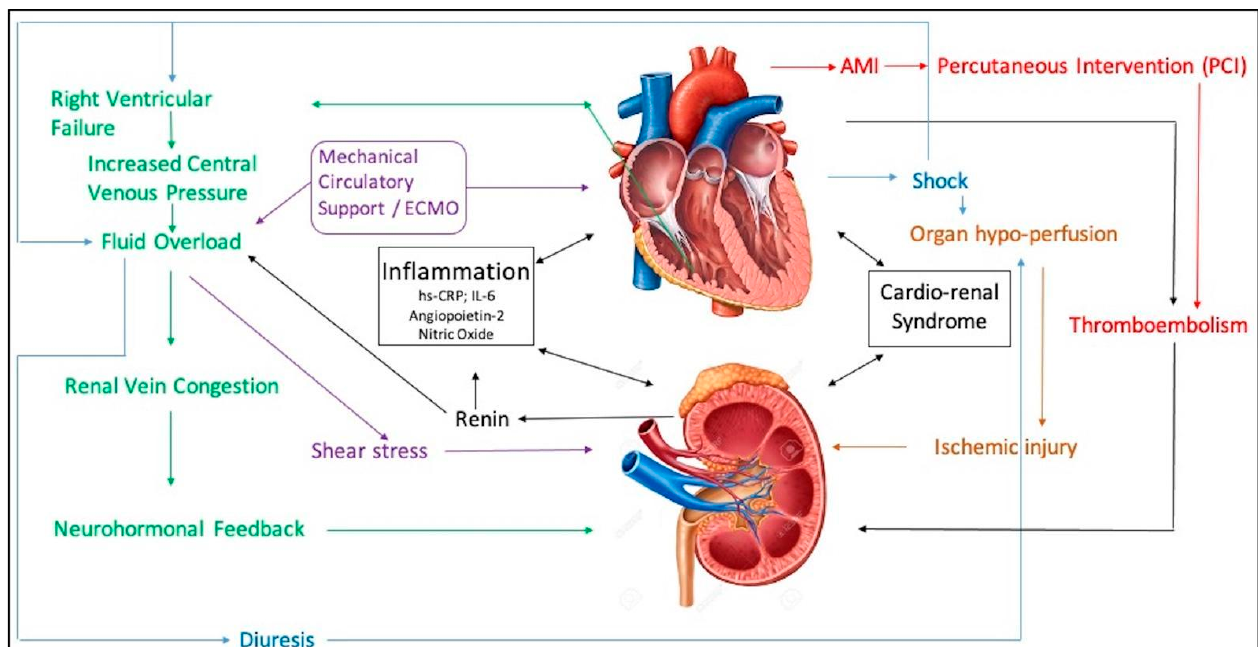
Figure 1. Pathogenesis of acute kidney injury in acute myocardial infarction with cardiogenic Table 1. Acute kidney injury in acute myocardial infarction-cardiogenic shock.